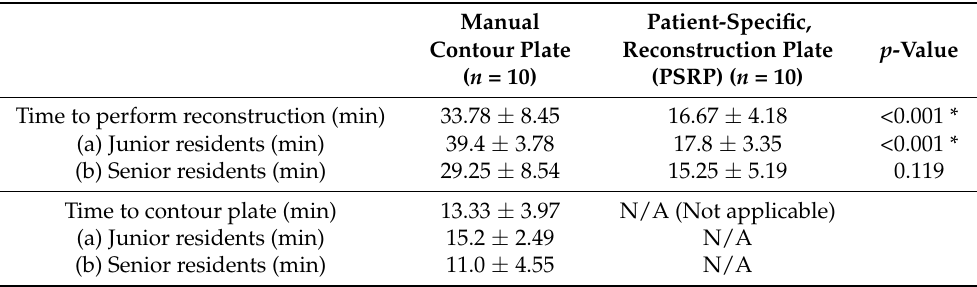
Table 1. Comparison of time to perform reconstructions in each group. Significant p -values are indicated with a (*).